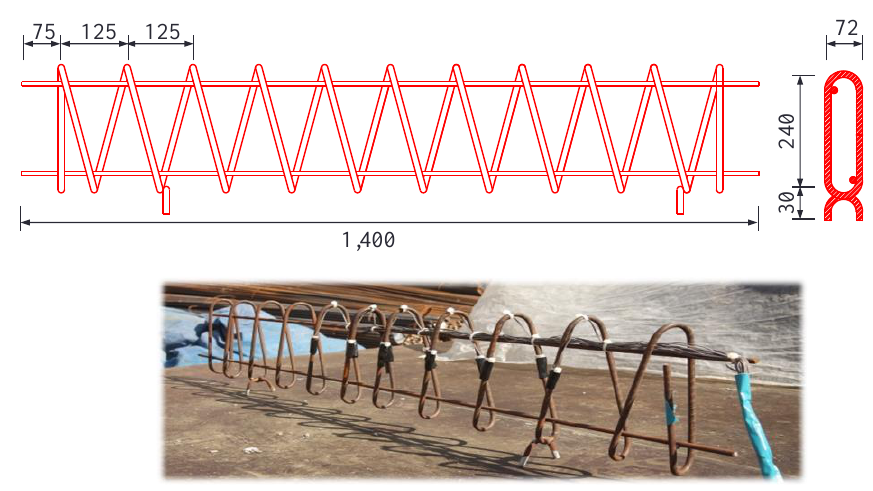
Figure 3. Details of shear reinforcement. (Unit: mm).